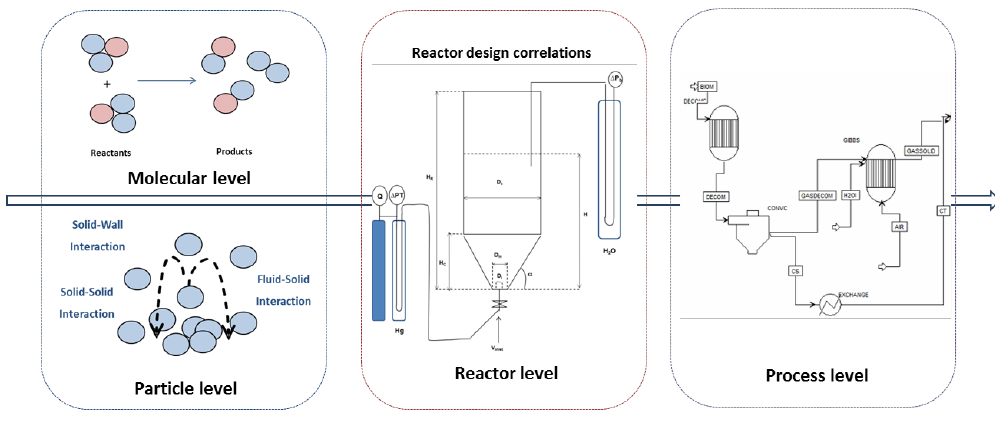
Figure 3. Multiscale analysis strategy.